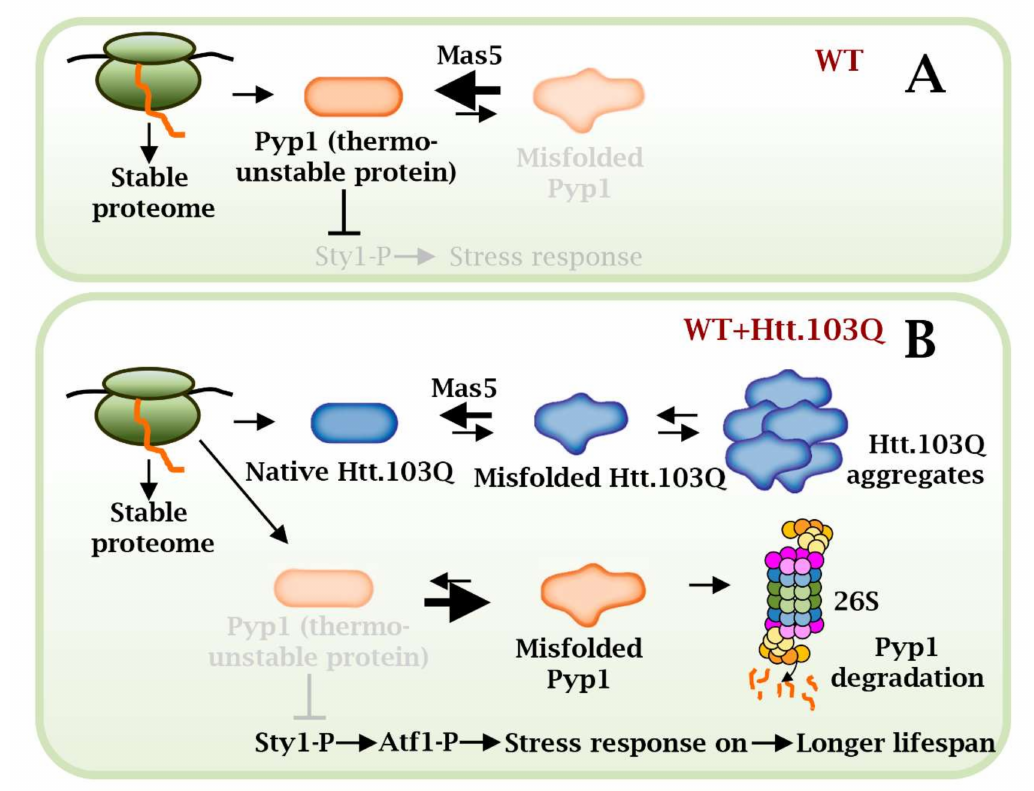
Figure 6. Scheme depicting a model of Mas5 role in in cells expressing or not Htt.103Q. ( A ) In basal conditions, Mas5 maintains the native conformation of the unstable Pyp1 phosphatase, which inhibits the MAP kinase Sty1. ( B ) However, in cells expressing Htt NTD .103Q-GFP, Mas5 participates in Htt NTD .103Q-GFP folding and leaves Pyp1 partially unattended. This promotes misfolding and degradation of Pyp1, with the subsequent activation of the Sty1- and Atf1-dependent stress